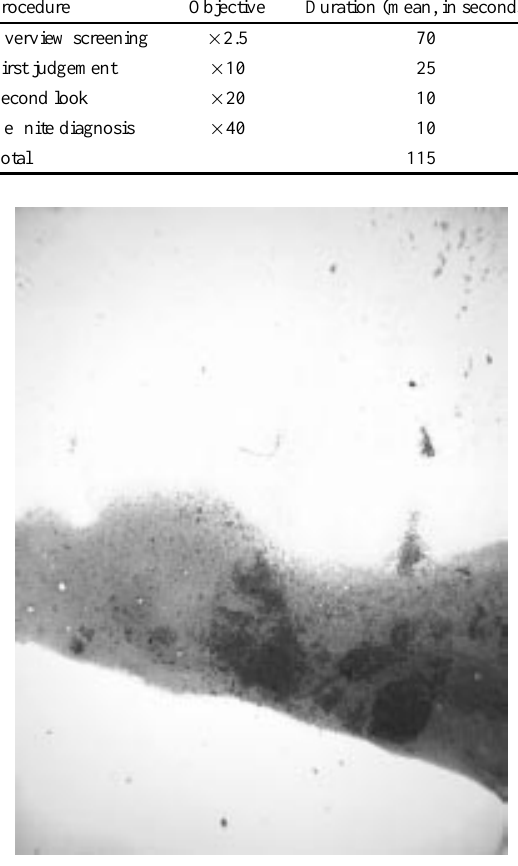
Fig. 1. Black-and-white image at low magnification ( (cid:2) 10) used for cellular screening.